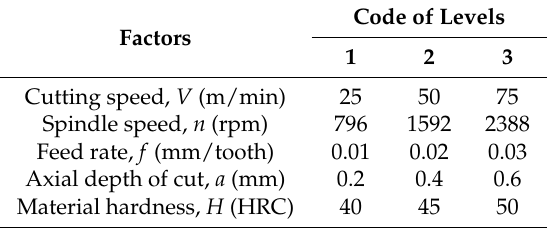
Table 3. Levels of input variables.